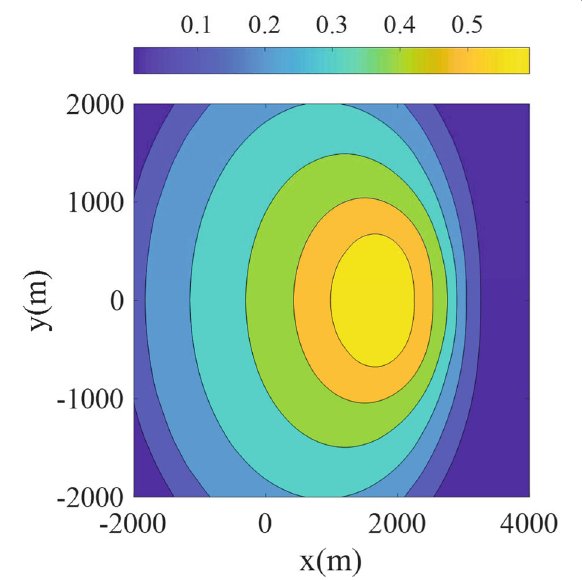
Fig. 4 The maximum achievable eavesdropping rate versus the position of E for AF relaying